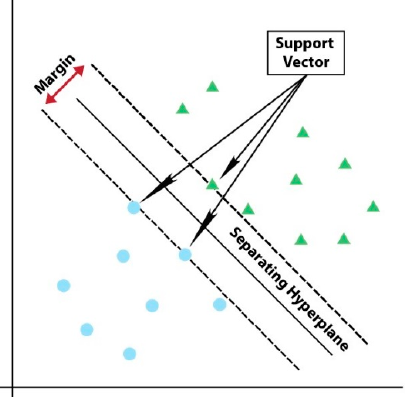
Figure 5. Support Vector Machine Algorithm.